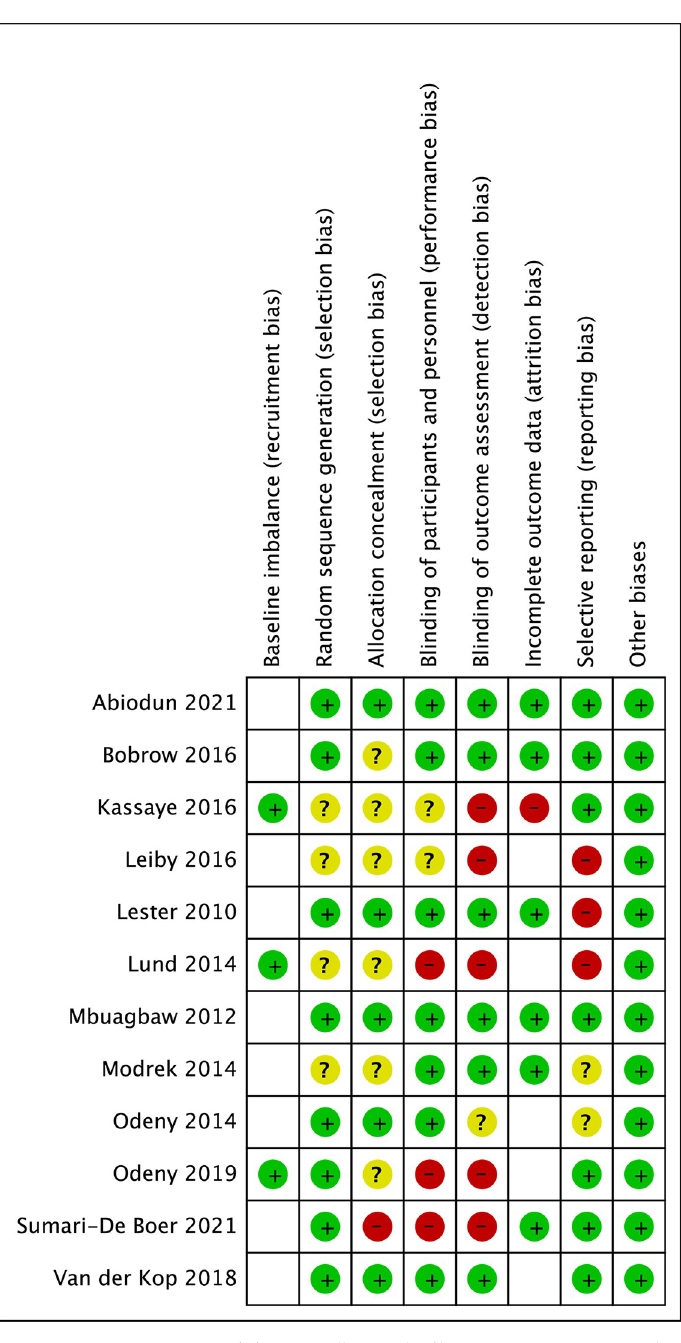
Fig 3. Risk of bias assessment � . � Empty cell: No risk of bias assessment—Attrition bias was not assessed for trials that only reported “appointment attendance” as an outcome as incomplete data is an integral part of this outcome.